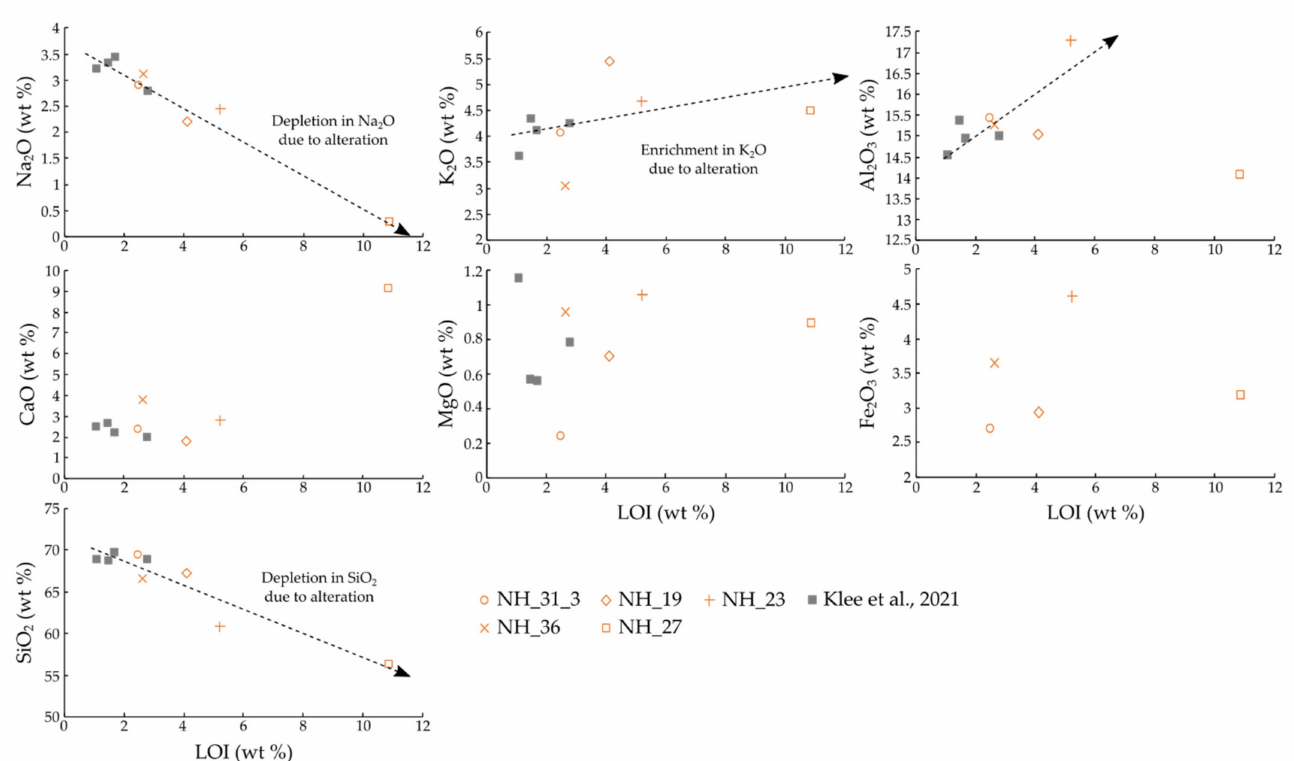
Figure 15. Plot of selected major element oxides (Na 2 O, K 2 O, Al 2 O 3 , CaO, MgO, Fe 2 O 3 , and SiO 2 ) versus loss on ignition (LOI) of samples from this study in orange and from [19] in grey. The dashed arrows show the different trends